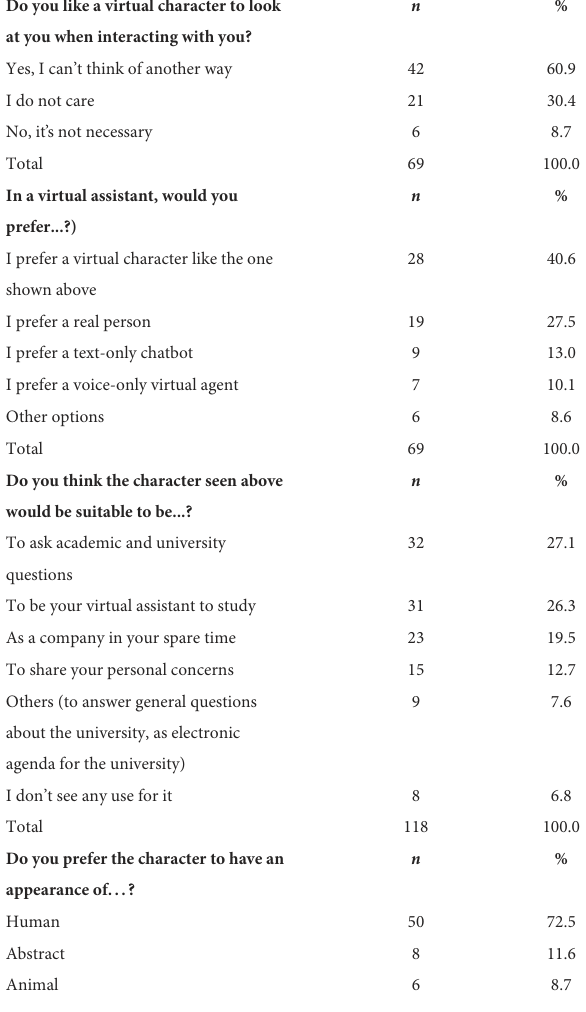
TABLE 7 Student opinion on several application aspects for each